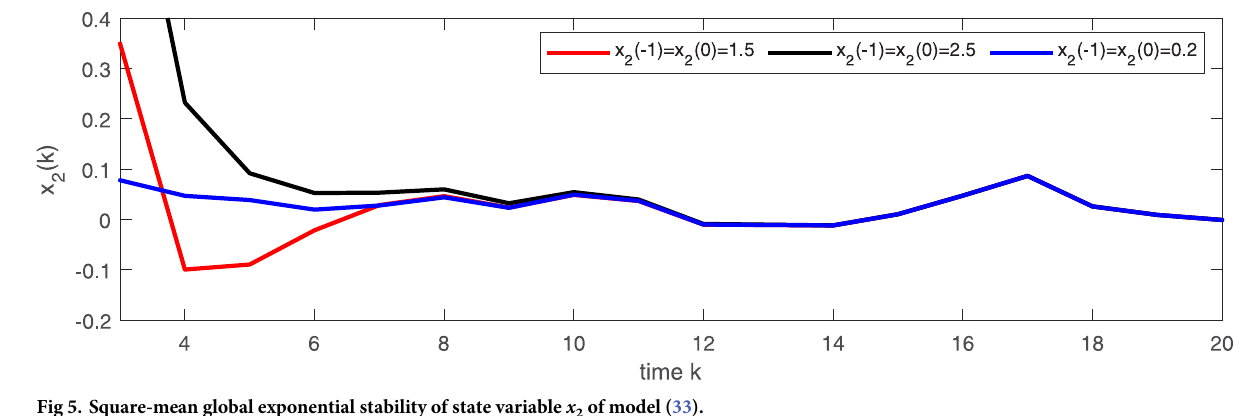
Fig 5. Square-mean global exponential stability of state variable x 2 of model